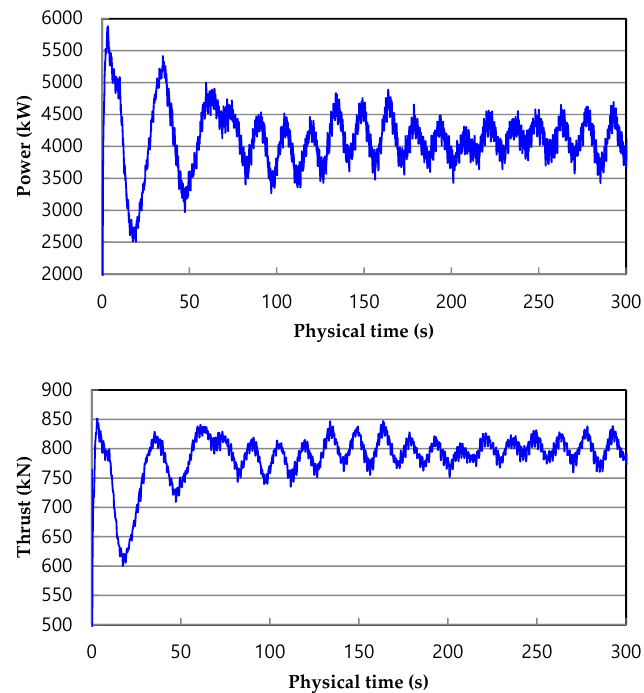
Figure 15. Fully coupled FOWT aerodynamic performance.